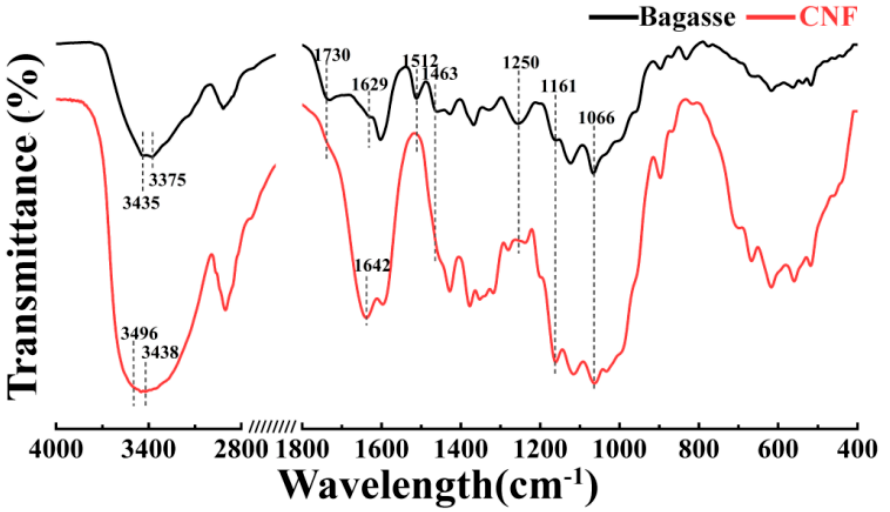
Figure 6. Fourier transform infrared (FTIR) spectra of the untreated bagasse and CNFs.